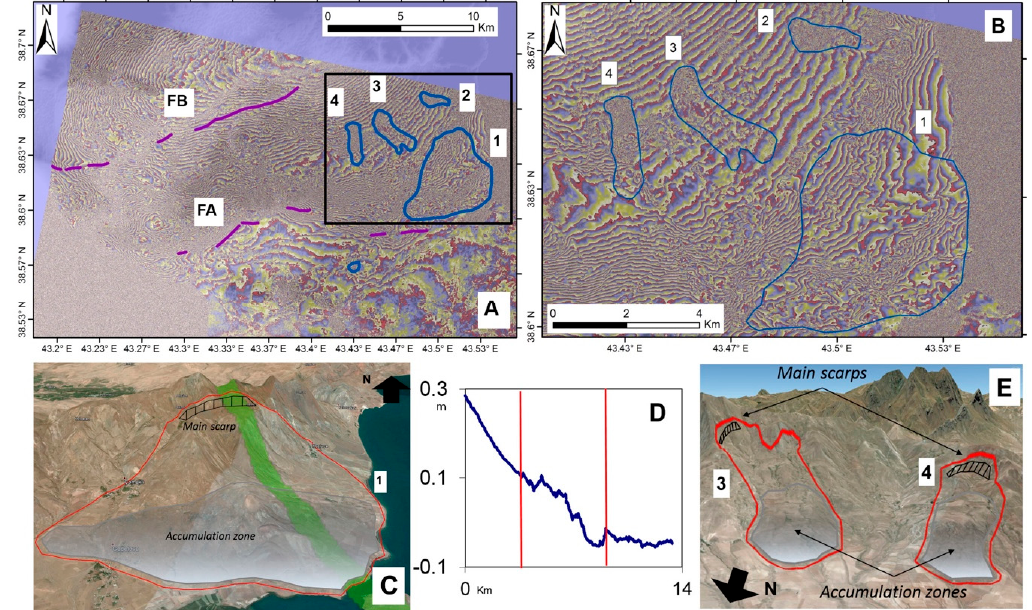
Figure 4. Fractures and landslides from InSAR: ( A ) wrapped phase of the CSK interferogram, where some crack lineaments (FA and FB, purple lines) and landslides (blue lines) are recognized; ( B ) zoomed view of the landslides; ( C ) Google Earth view from South of landslide 1 (red lines); and in green the displacement profile shown in ( D ), where the two red bars indicate the DGSD body; ( E ) Google Earth view from NNW of landslides 3 and 4, indicated in red.